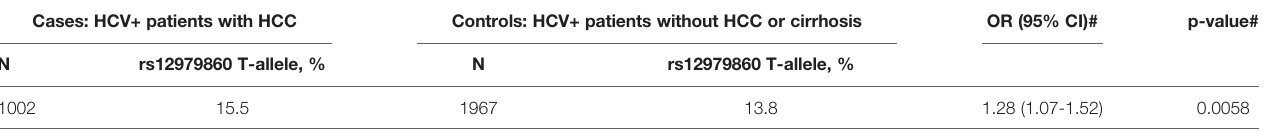
TABLE 1 | IFNL4 genotype is associated with increased risk of HCC in HCV-infected patients in Japan. Cases: HCV+ patients with HCC Controls: HCV+ patients without HCC or cirrhosis